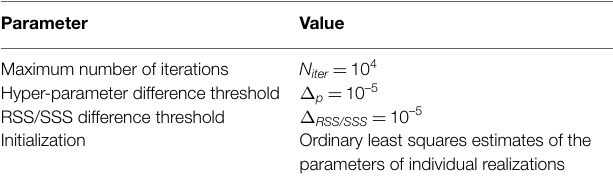
TABLE 1 | Settings of the EM